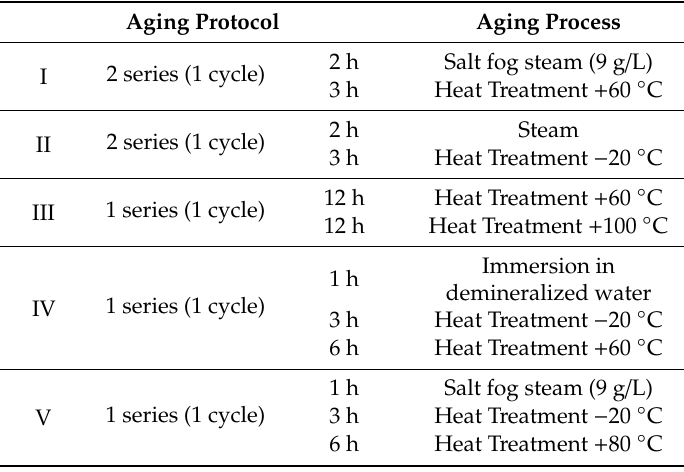
Table 2. Accelerated aging protocols.